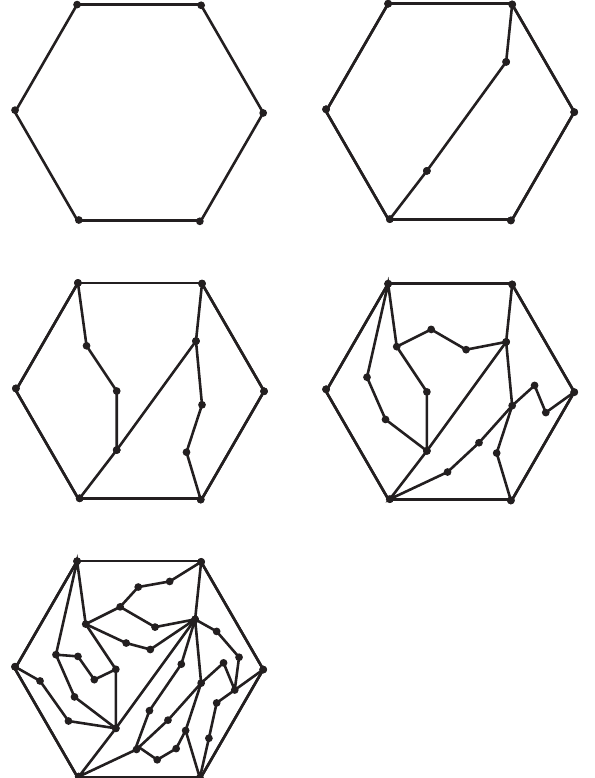
Figure 4. Construction of the hexagon-based network (up to 4th